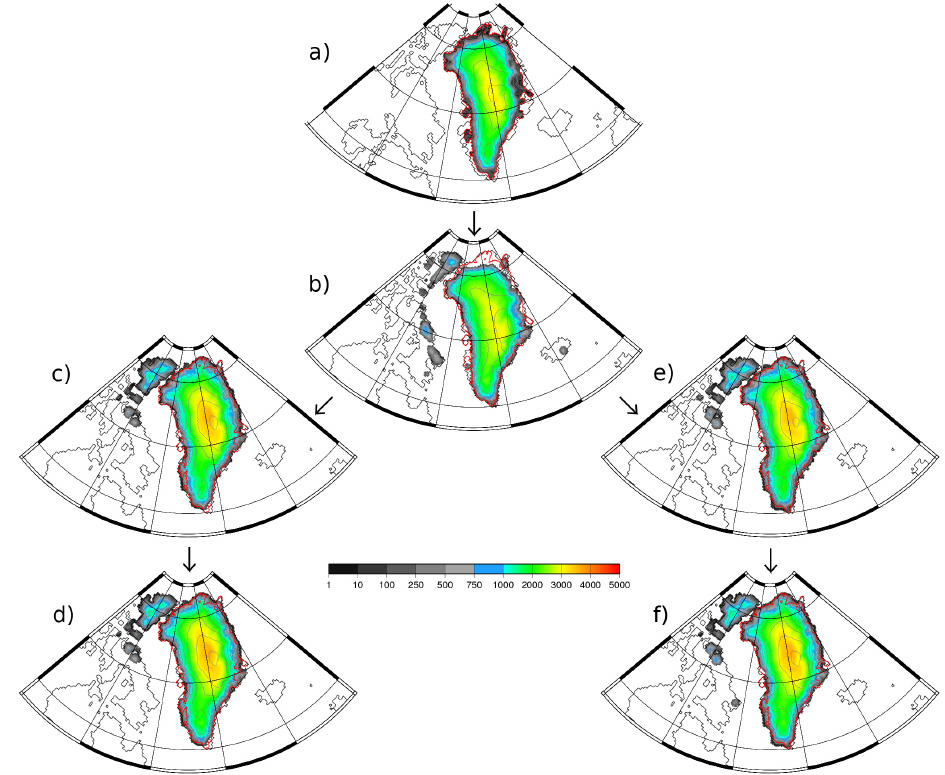
Figure 9. Ice-sheet thickness (in m) for the observations and the experiments performed. (a) Observed Greenland thickness (Bamber et al., 2001) interpolated to the GRISLI grid (b) is the CLIMICE offline simulation, (c) the SNOW-SO semi-offline, (d) the SNOW, (e) the PRECIP-SO semi-offline and (f) the PRECIP simulations. The red contour line corresponds to the observed present-day ice